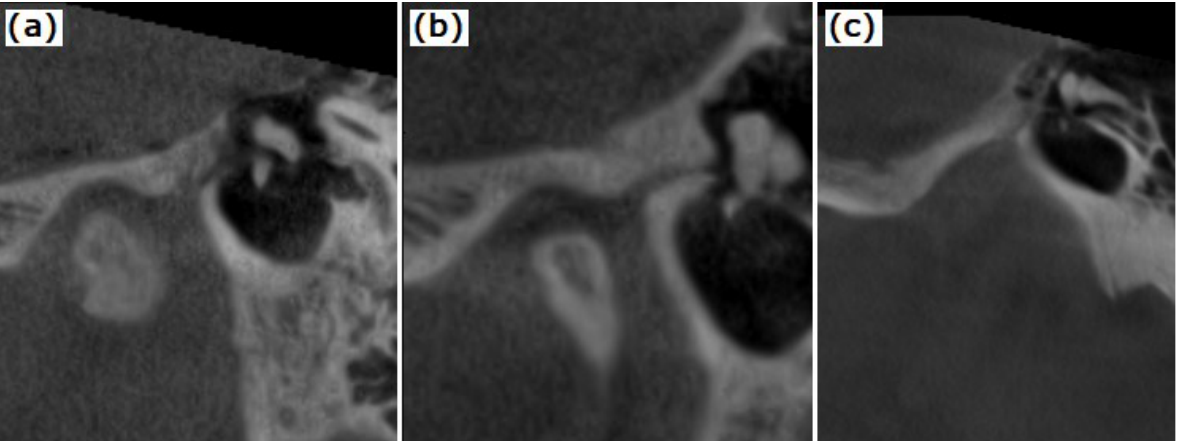
Figure 2. PTF types — ( a ) type 1: broad tunnel-shaped structure; ( b ) type 2: tunnel-shaped structure widely open in the entrance to the mandibular fossa and gradually thinning out in the tympanic cavity; ( c ) type 3: tunnel-shaped structure widely open in the entrance of the mandibular fossa and narrow egress in the tympanic cavity.